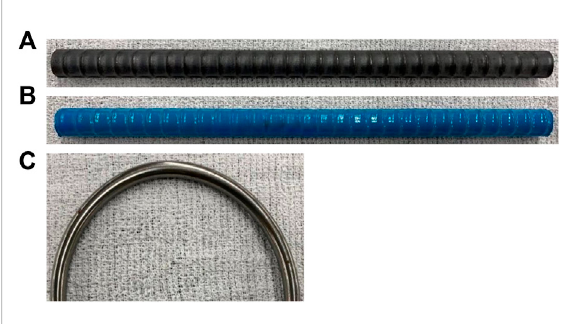
FIGURE 1 Types of rebar (A) normal deformed rebar, (B) epoxy resin- coated rebar, and (C) tie